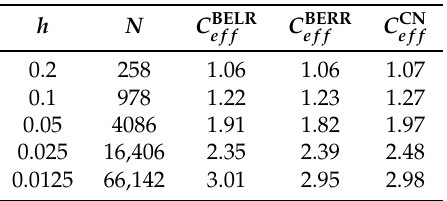
h N C BELR C BERR C CN ef f ef f ef f